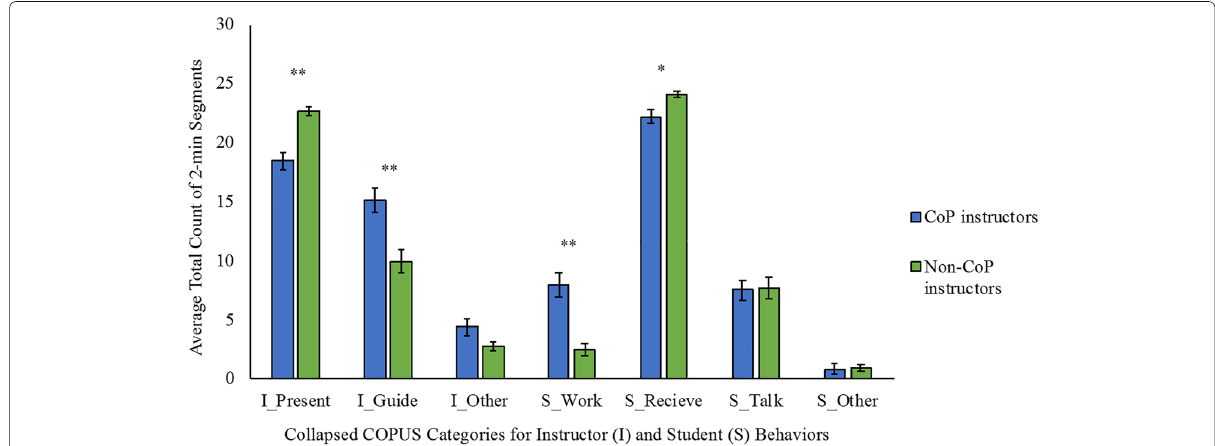
Fig. 1 Student and instructor behavior frequency. Comparison of mean counts for collapsed COPUS categories by CoP ( n = 25) and non-CoP ( n = 35) instructors. Significant differences using Kruskal-Wallis tests: * p < .05 , ** p <